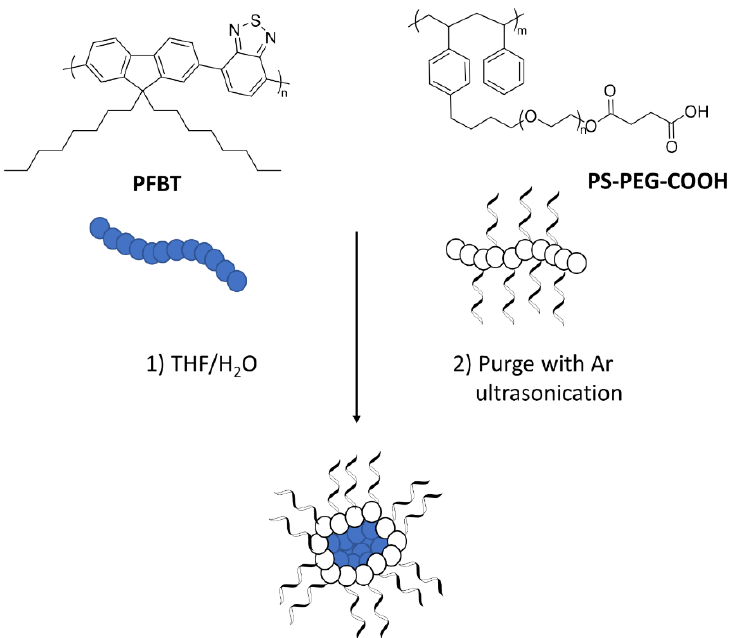
Figure 39. Synthetic outline of the PDots tested for photocatalytic hydrogen evolution [36].